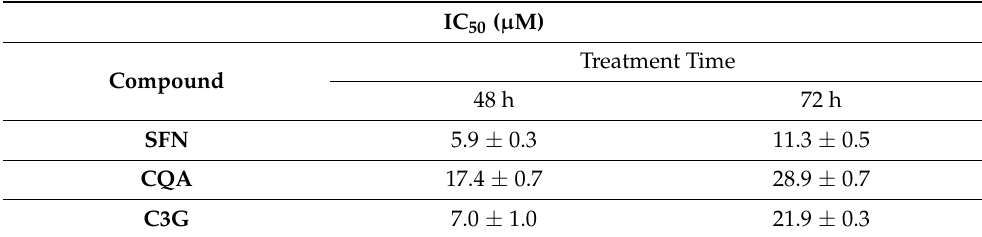
Table 1. IC 50 values of active cytotoxic